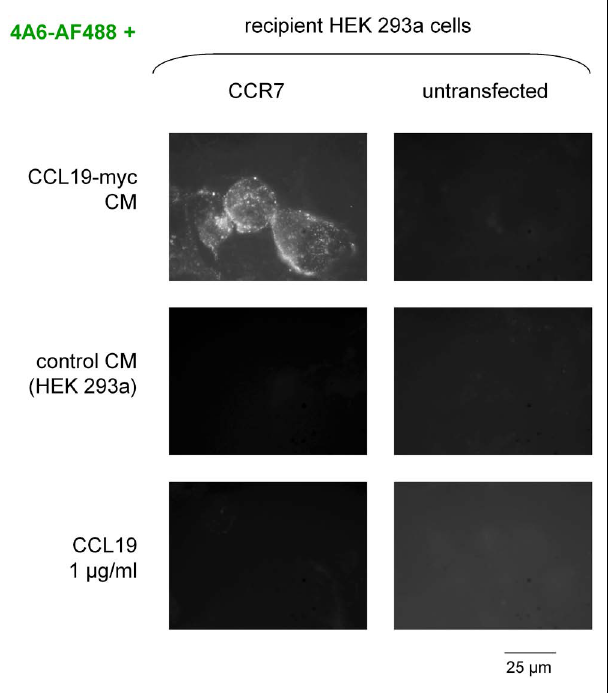
FIGURE 2 | Endocytosis of the anti-myc monoclonal antibody (clone 4A6, conjugated toAlexaFluor-488, final concentration in the culture medium 3.3 nM) as determined by co-treatment with the CCL19-myc construction in intact HEK 293a cells that optionally and transiently expressed CCR7. A control conditioned medium (CM) or authentic CCL19 were used as control stimuli.The undiluted CM were transferred for a 30-min incubation period before rinsing and observation. Original magnification × 1000.